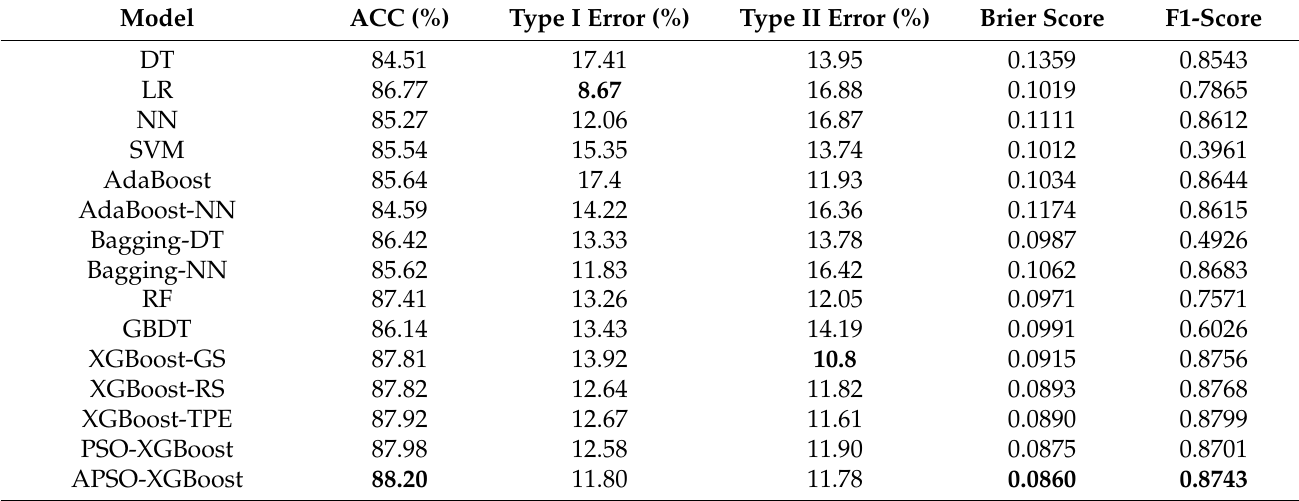
Table 8. Results of the measured performance of models on the Australian data